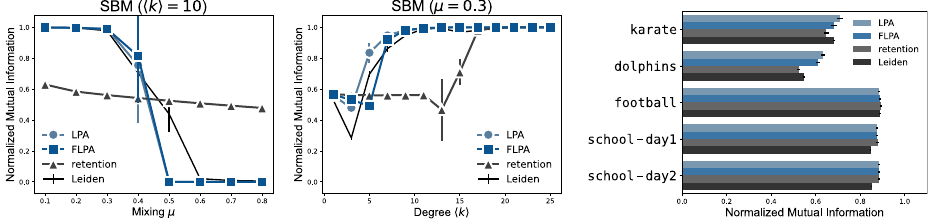
Figure 4. Accuracy of partitions for stochastic block model graphs with n = 10 5 nodes and (left) varying mixing parameter µ , where higher µ corresponds to partitions that are more challenging to detect, or (middle) varying average degree (cid:31) k (cid:30) , and (right) small social networks with the metadata on node clusters.